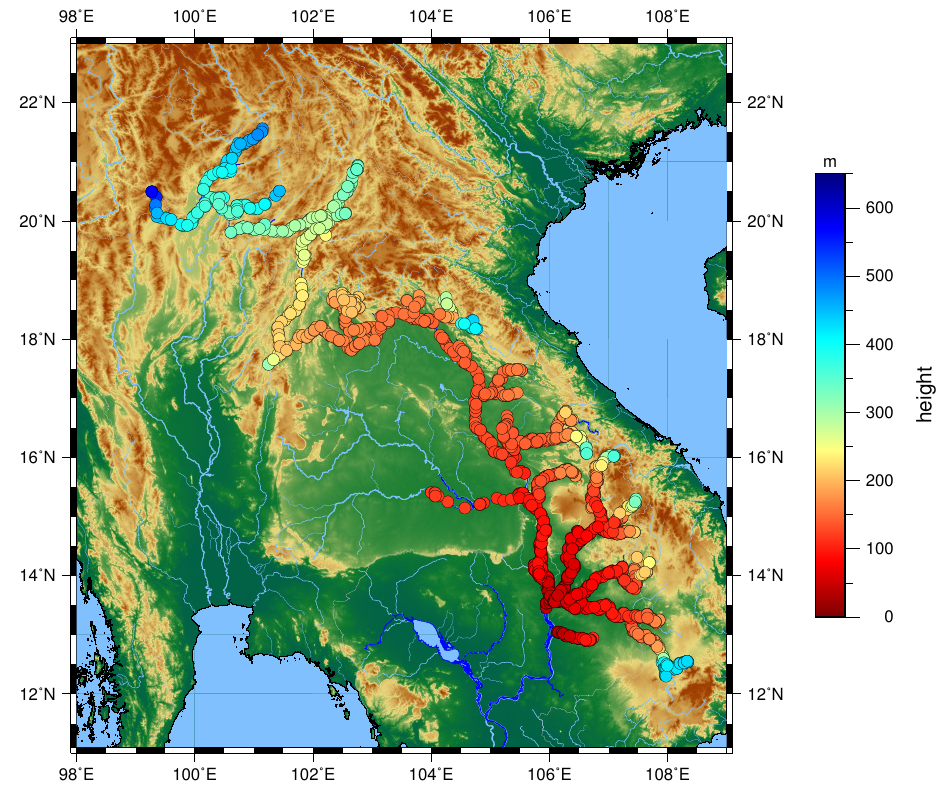
Figure 8. Resulting water levels in the Mekong River